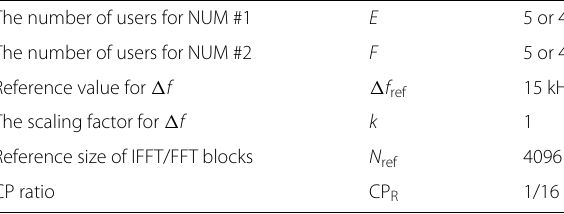
Table 4 Simulation parameters for multiple